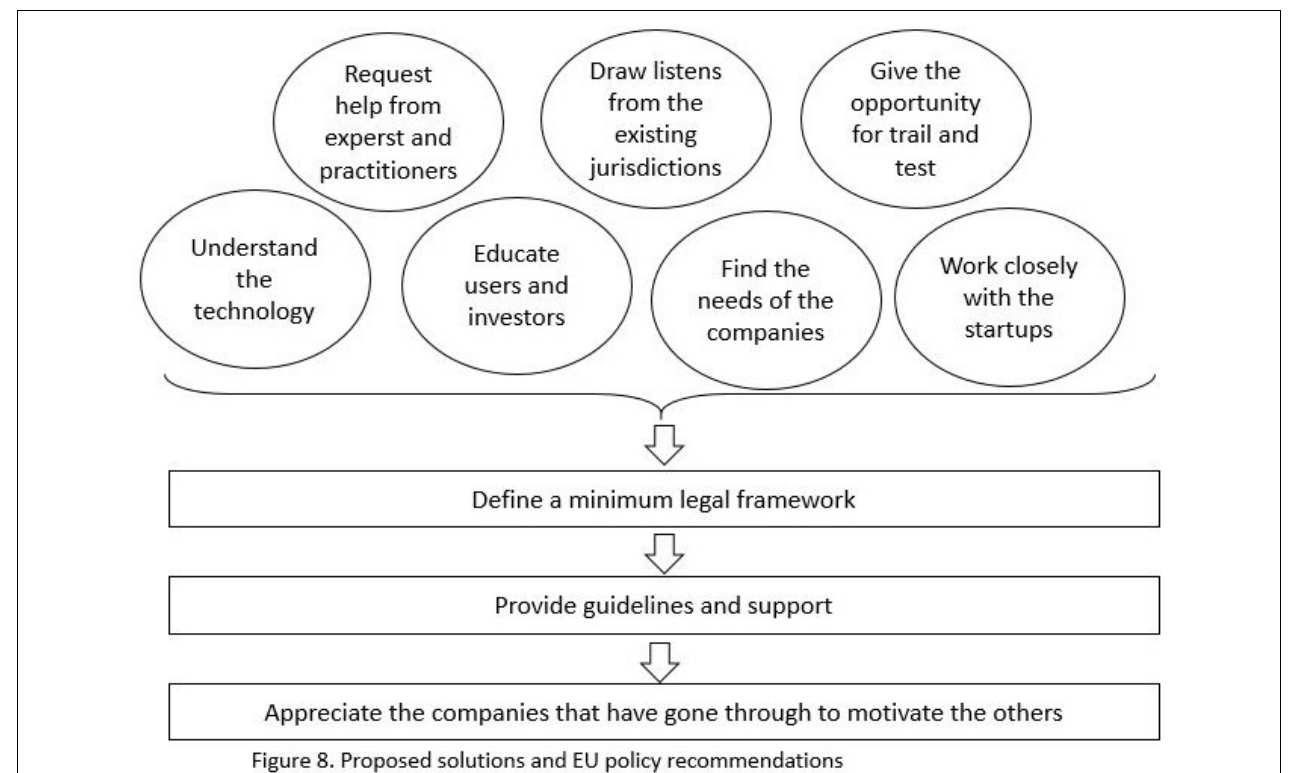
FIGURE 4 | Proposed solutions and EU policy